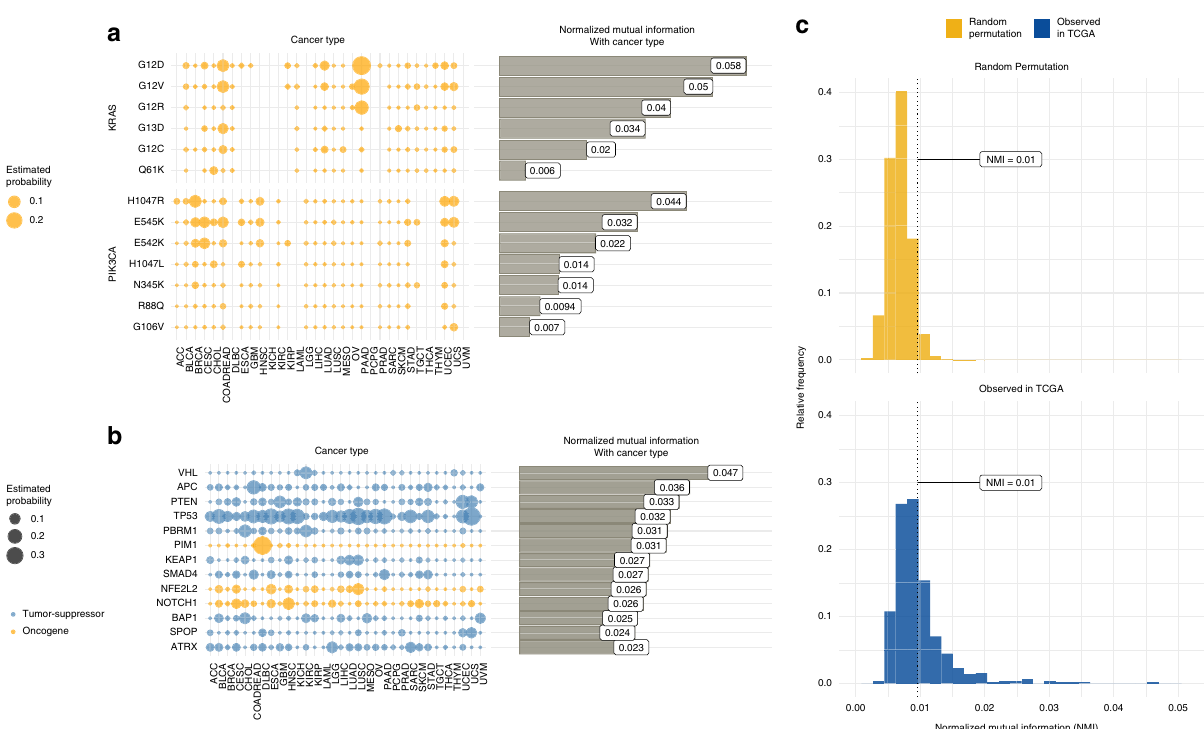
Fig. 3 Estimating gene and tissue-type speci fi c variant probabilities. a , b Gene and tissue-type speci fi c probabilities of encountering a previously seen variant ( a ) and at least one hitherto unseen variant ( b ) in a new tumor differ substantially across genes and tissue-types. The dependencies between the tissue type and the occurrences of gene speci fi c variants, both previously observed ( a ), and hitherto unobserved ( b ), as quanti fi ed by Mutual Information, vary substantially across genes. Oncogenes are shown in orange, tumor-suppressor genes are in blue, and non-annotated (in OncoKB list) genes are shown in gray. c The tissue speci fi city for observing at least one new variant in a gene in TCGA data, as quanti fi ed by NMI values (blue histogram), shows a distinct right shift as compared to the null reference NMI values obtained from random variant-tissue allocations (orange histogram). The dotted vertical line corresponds to the 95 th percentile of the null reference